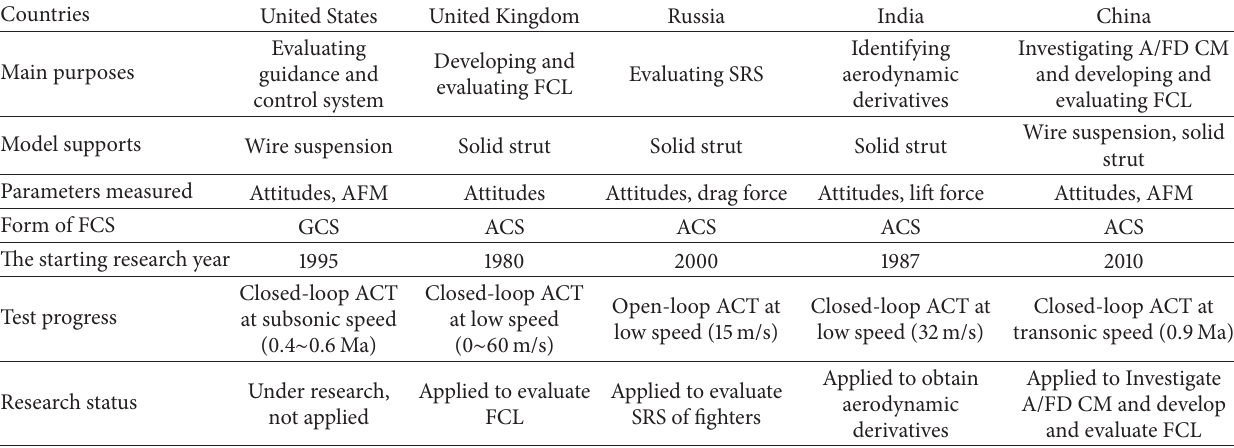
Table 3: VFT progress of the main countries developing VFT techniques.